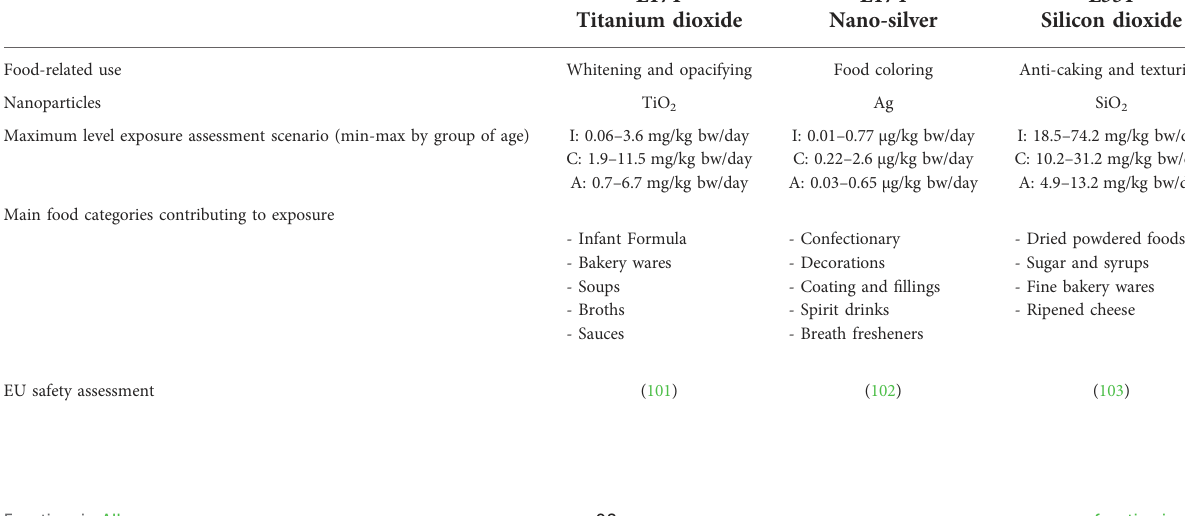
TABLE 1 Summary of common food-related usages of E171, E174 and E551, and of total estimated exposure in humans in a maximum level exposure scenario per group of age. I: Infants (12 weeks – 11 months), C: Children (3 – 9 years), A: Adults (18 – 64 years) in mean (minimum-maximum) across the dietary surveys in mg/kg or µg/Kg body weight (bw)/day, according to EFSA risk assessment in